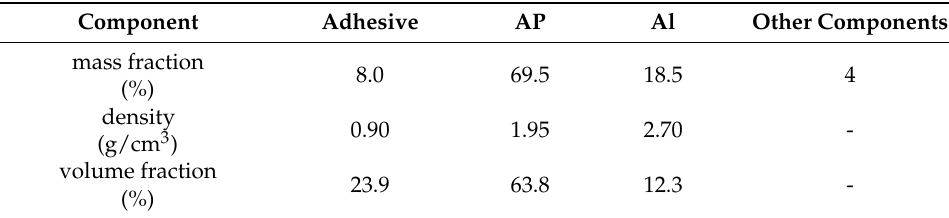
Table 1. Typical composition of HTPB propellant.